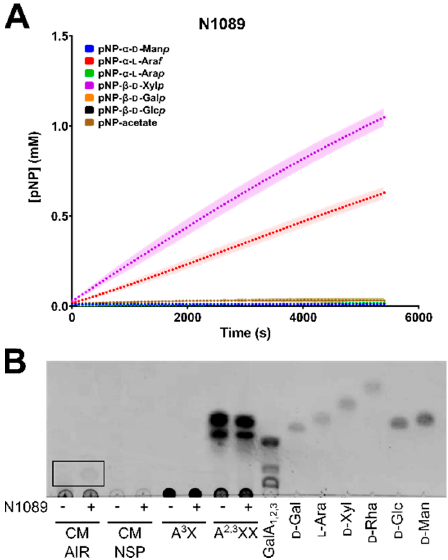
Figure 7. Enzymatic assays for CAZyme activity characterization. Full-length soluble enzymes ( A ) N1089 was incubated with pNP-conjugated substrates, and monitored spectrophotometrically at OD405 nm over a period of 90 min. A standard curve was generated of OD405 nm vs concentration of pNP in order to calculate final product formed by enzyme addition. Plotted points represent an average of three technical replicates, with the standard deviation from the mean shown as a shadow. ( B ) Thin-layer chromatography (TLC) of commercial and synthetic polysaccharides incubated without ( − ) and with (+) N1089 enzyme. Polysaccharide substrates consisted of: canola meal (CM) alcohol insoluble residue (AIR), CM non-starch polysaccharide (NSP), 3 2 - α -L-arabinofuranosyl-xylobiose (A 3 X), 2 3 ,3 3 -di- α -L-arabinofuranosyl-xylotriose (A 2,3 XX), or a galacturonic acid ladder of mono, di, and triose forms (GalA 1,2,3 ). Monosaccharide standards were included as controls; D-galactose (D-Gal), L-arabinose (L-Ara), D-xylose (D-Xyl), D-rhamnose (D-Rha), D-glucose (D-Glc), and D-mannose (D-Man). TLC solvent was composed of 2:1:1 butanol:acetic acid:H 2 O and plates were stained with 1%